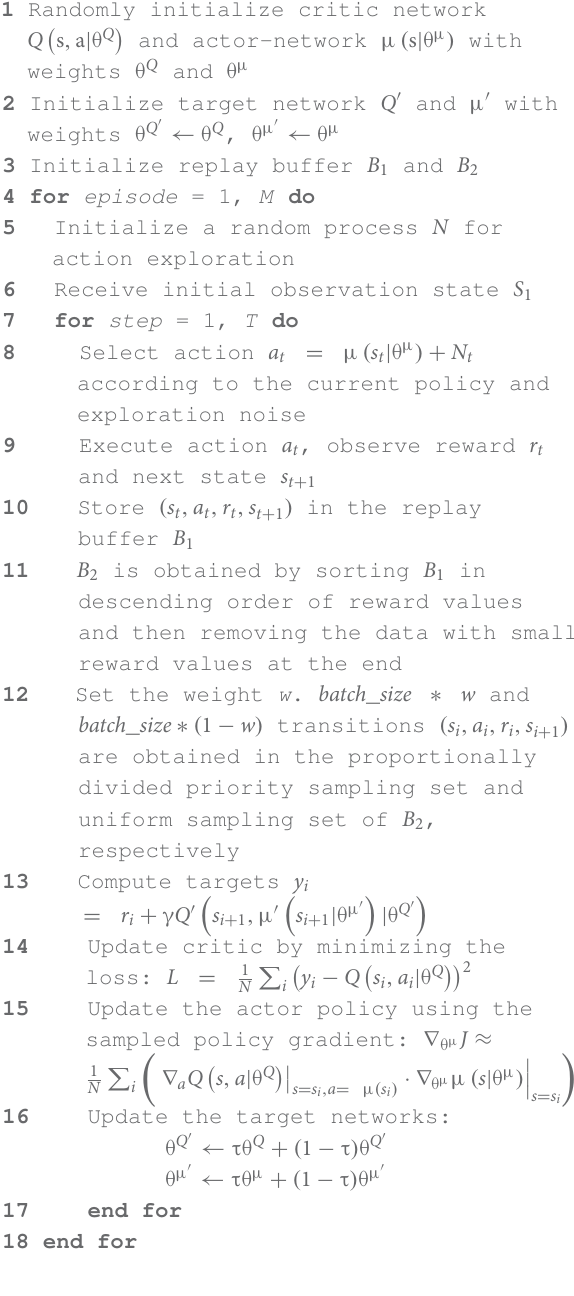
Algorithm 1. Improved deep deterministic policy gradient (DDPG)